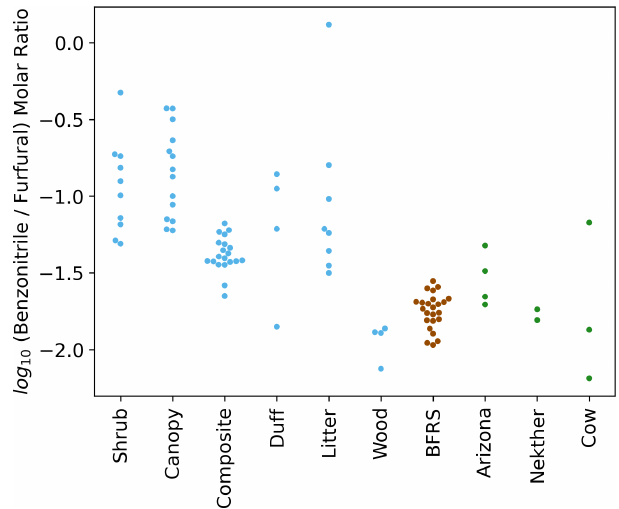
Figure 6. Swarm plots of the log-transformed ratio of biomass- burning tracers benzonitrile and furfural for the Fire Lab 2016 labo- ratory study (shrub, canopy, composite, duff, litter, and wood fuels), the Blodgett study (BFRS) (Hatch et al., 2019), and the wildfires in this